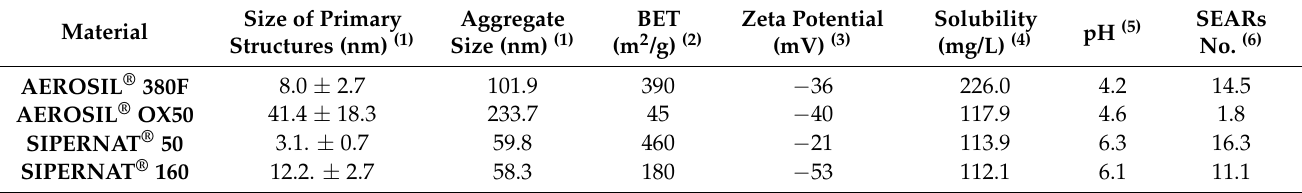
Table 1. Material properties of the synthetic amorphous silica (SAS) used in the